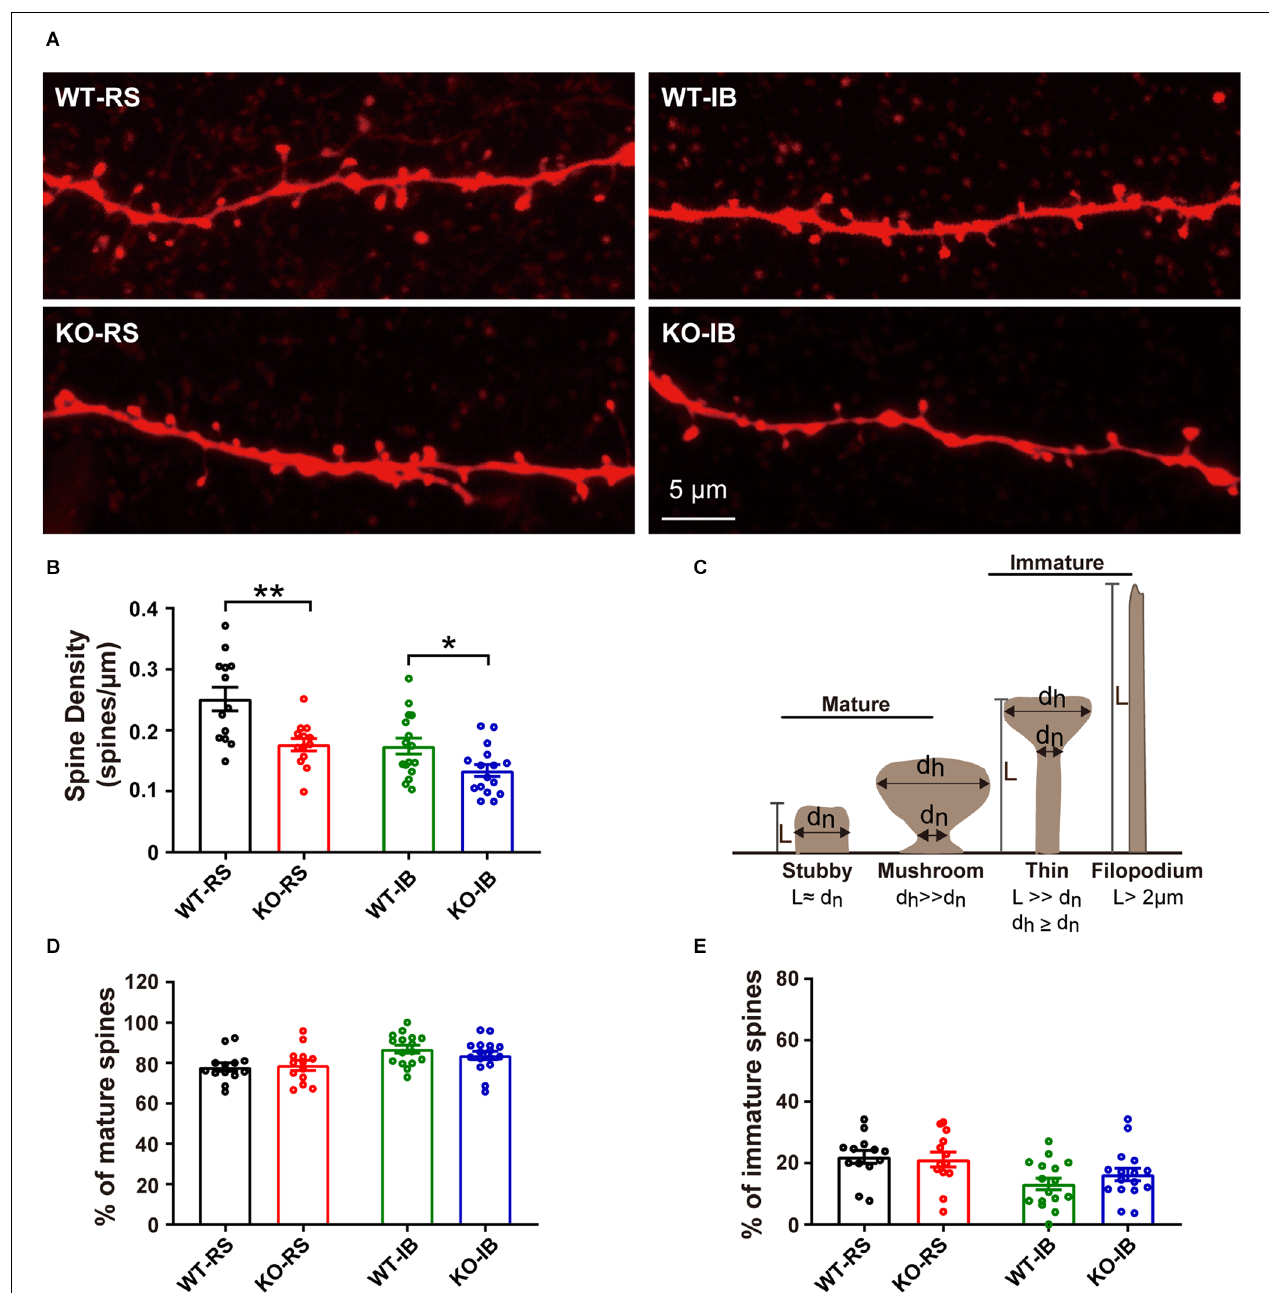
FIGURE 5 | Density of dendritic spines of L5 pyramidal neurons in S1BF of adult WT and KO mice. (A) Representative images of dendrites in RS and IB neurons from p53KO and WT mice. (B) Quantification of spine density (WT-RS vs. KO-RS, t (24) = 3.396, p = 0.0024; WT-IB vs. KO-IB, t (30) = 2.444, p = 0.0206; unpaired t -test). (C) Schematic representation of morphological classification of dendritic spines. (D) Quantification of percentages of mature spine (WT-RS vs. KO-IB, t (24) = 0.2571, p = 0.7993; WT-IB vs. KO-IB, t (30) = 1.107, p = 0.2772; WT-RS vs. WT-IB, t (27) = 3.142, p = 0.0040; KO-RS vs. KO-IB, t (27) = 1.552, p = 0.1324; unpaired t -test). (E) Quantification of percentages of immature spine (WT-RS vs. KO-RS, t (24) = 0.2571, p = 0.7993; WT-IB vs. KO-IB, t (30) = 1.107, p = 0.2772; WT-RS vs. WT-IB, t (27) = 3.142, p = 0.0040; KO-RS vs. KO-IB, t (27) = 1.552, p = 0.1324; unpaired t -test). Number of mice and neurons used in (B,D,E) : from RS (WT, n = 13; KO, n = 13) and IB (WT, n = 16; KO, n = 16) cells in WT ( N = 6) and KO mice ( N = 9). * p < 0.05; ** p <